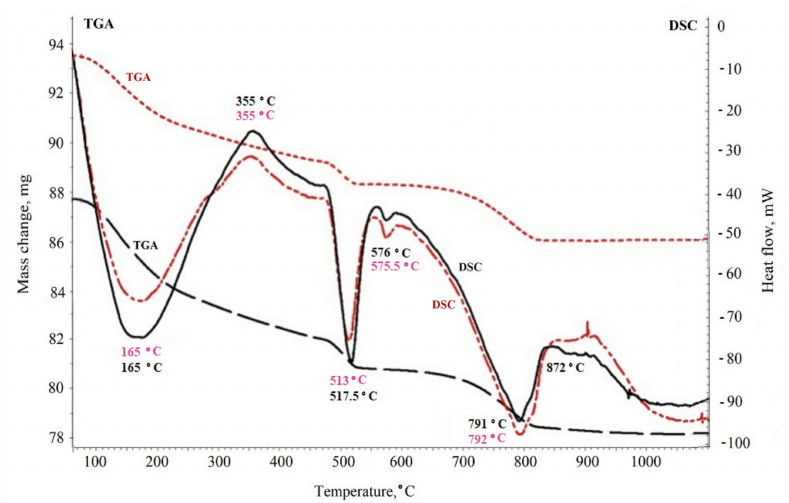
Figure 9. Differential scanning calorimetry and thermogravimetric analysis patterns of samples with carbon black cured for 28 days under normal conditions (black curves: sample without additives; red curves: sample modified with 0.005% carbon